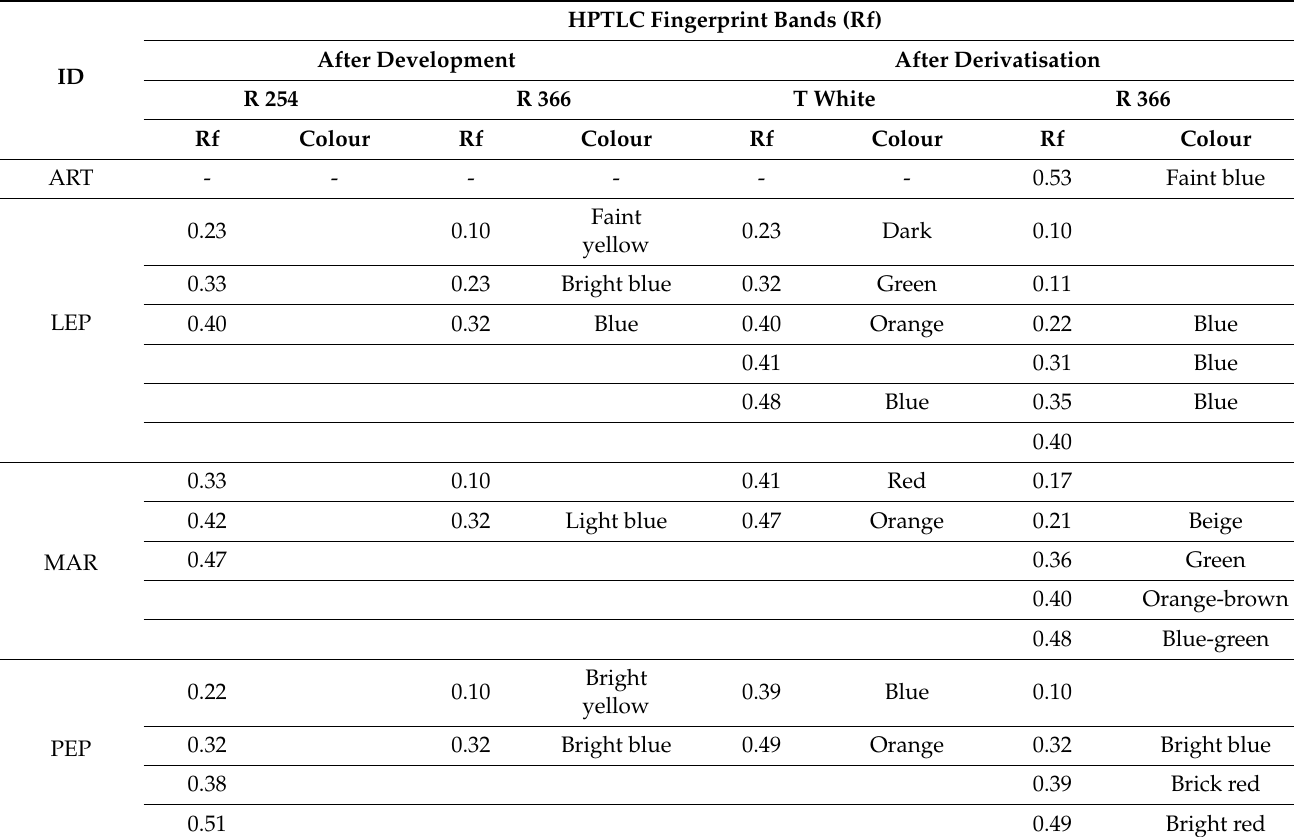
Table 1. Baseline HPTLC fingerprints of honeys (key band positions at specific Rf and